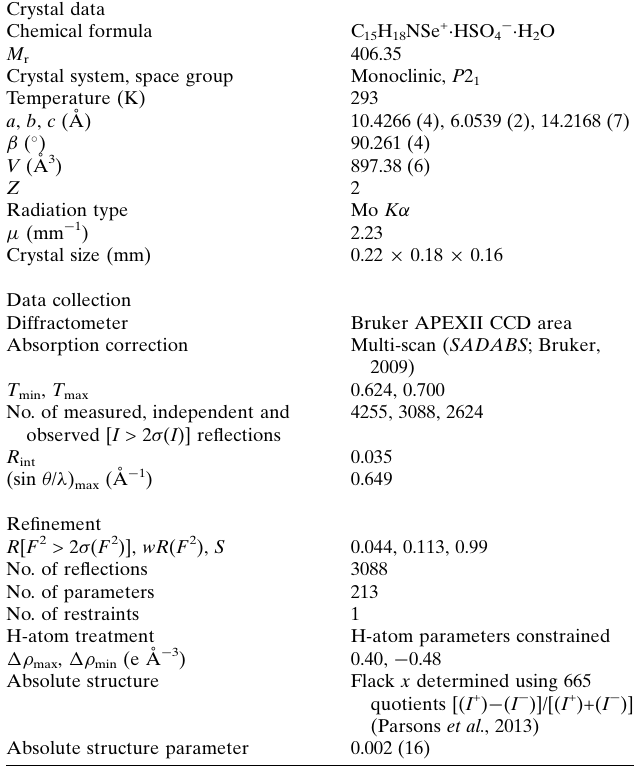
Crystal data Chemical